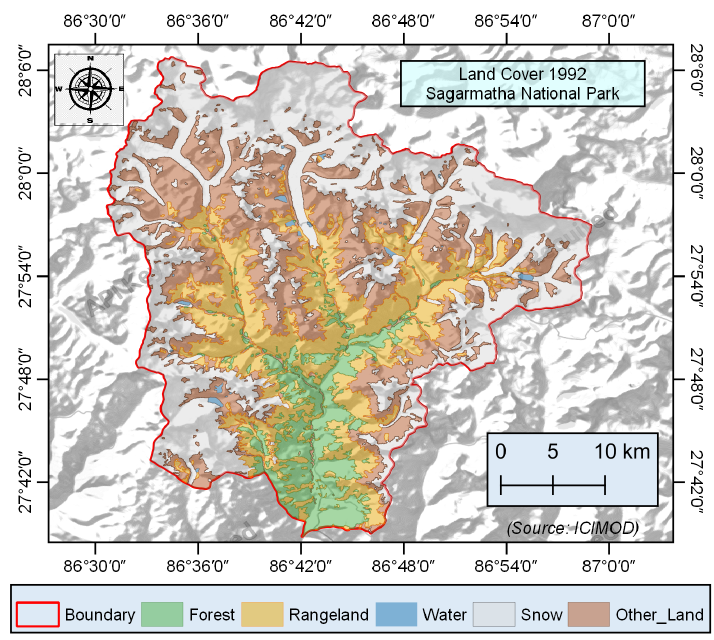
Figure 1. Land cover map of the study area (Sagarmatha National Park).